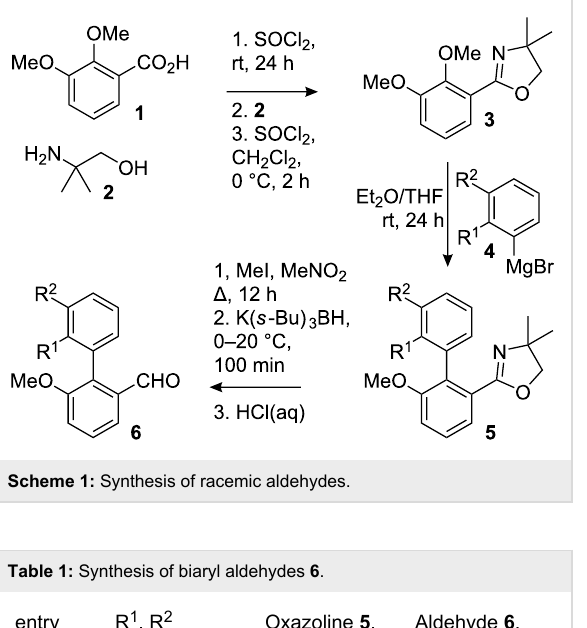
Table 1: Synthesis of biaryl aldehydes 6